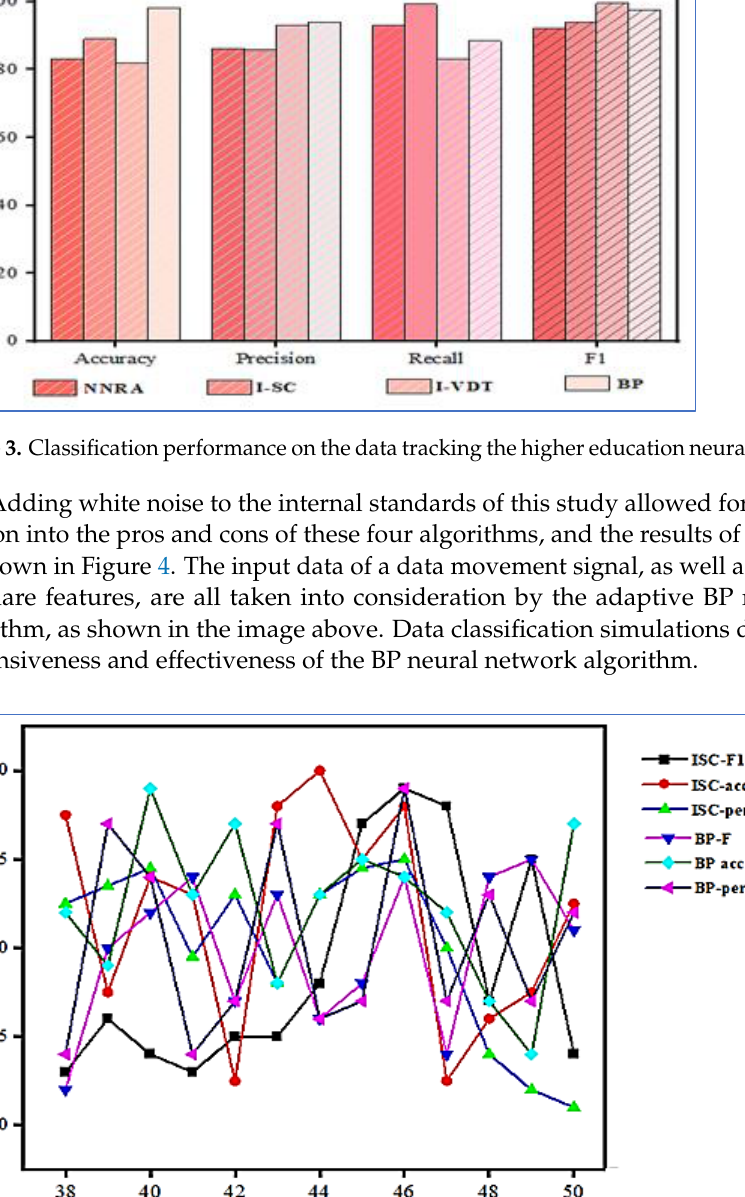
Figure 5. F1 data categories of the BP neural network with three varying inputs for the vocational course.